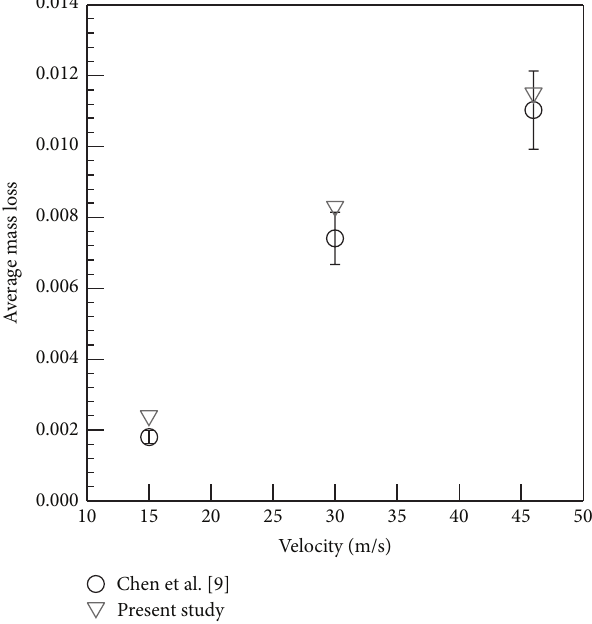
Figure 3: Comparison of average mass loss variations with previous